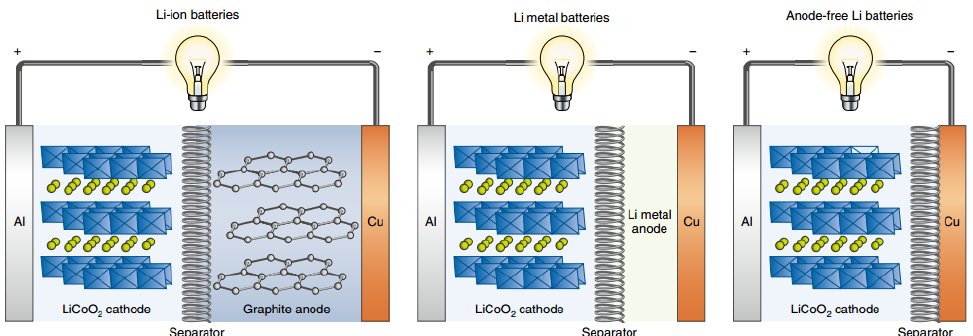
Figure 2. Differences in battery manufacturing and related improvement in volumetric and gravimetric energy density (adopted and modified from [31]).